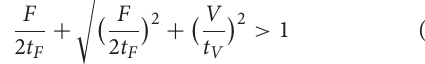
FIGURE 6 | Failure envelopes corresponding of Equations (66) and (73), presently denoted FC-1 and FC-2, shown for k = 0.5, k = 0.6, k = 0.7, k = 0.8, k = 0.9 and k = 1.0. The gray-shaded regions correspond to load combinations for which “beam” elements do not break, i.e., safe loading